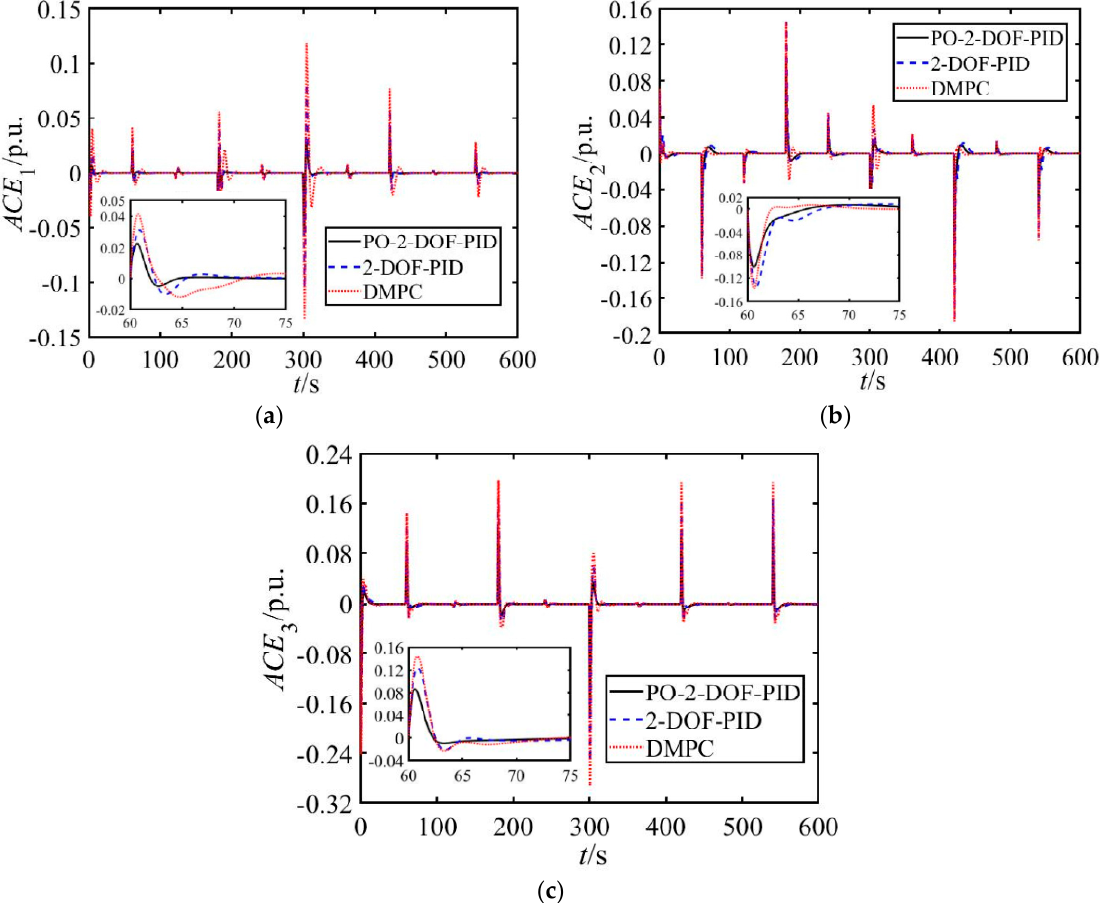
Figure 8. ACE of power system in high wind speed. ( a ) Area1 ( b ) Area2. ( c ) Area3.